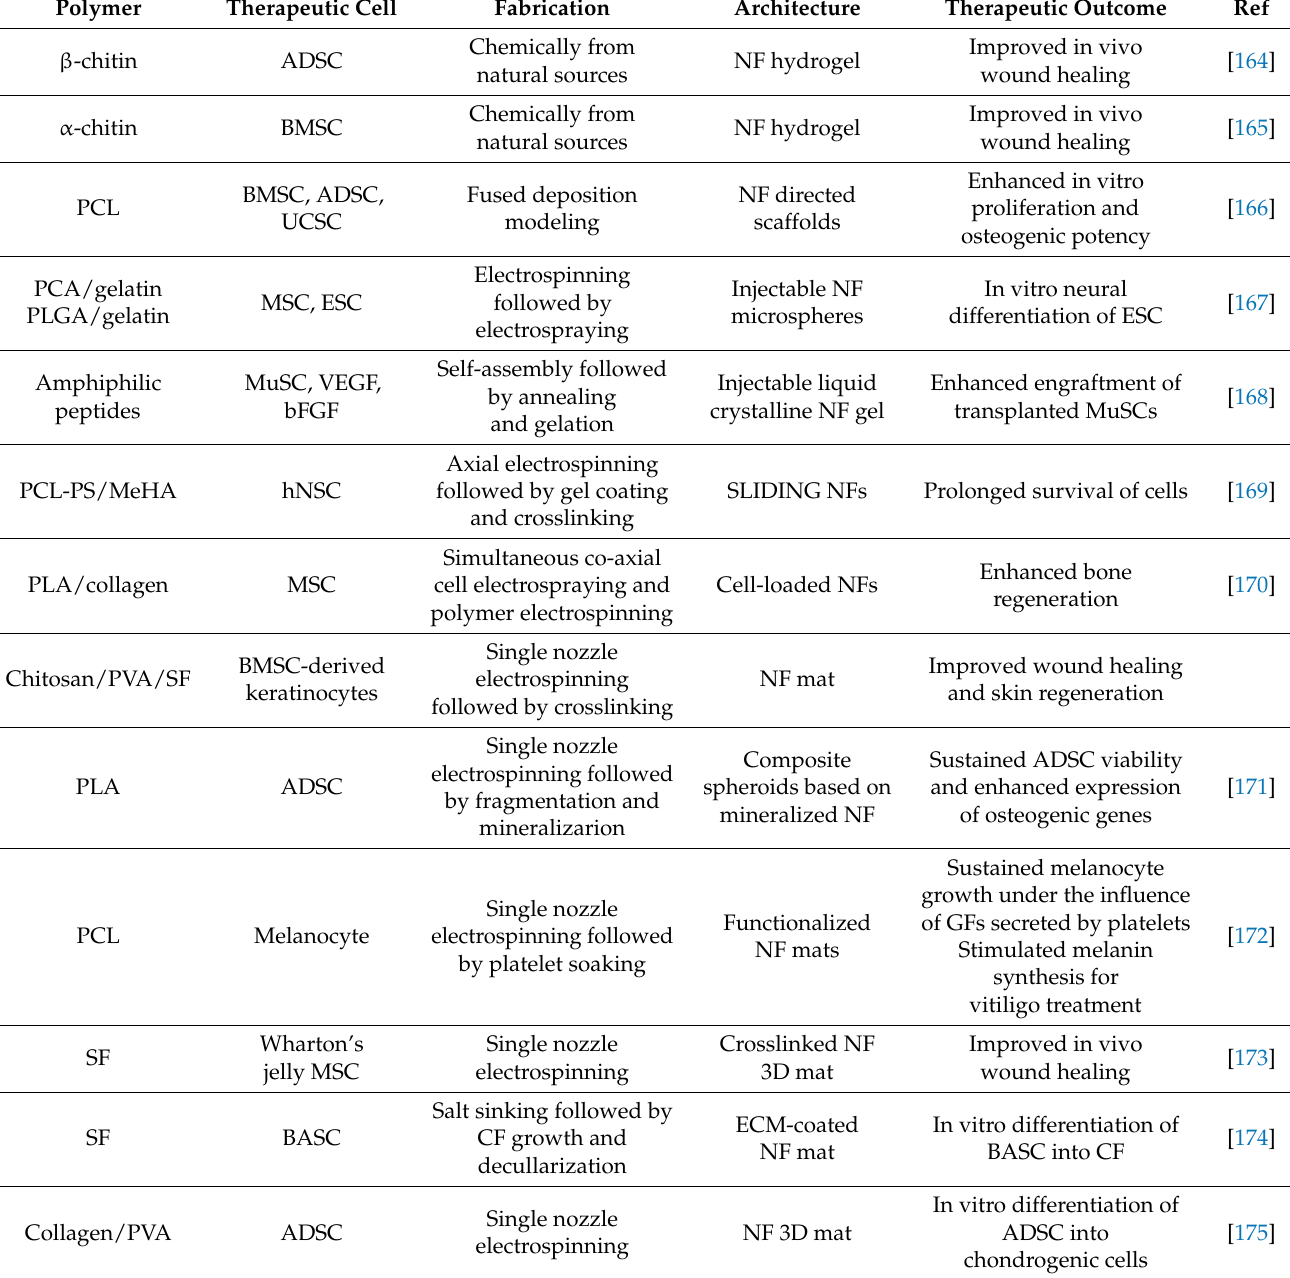
Table 5. Nanofiber systems used for delivery of